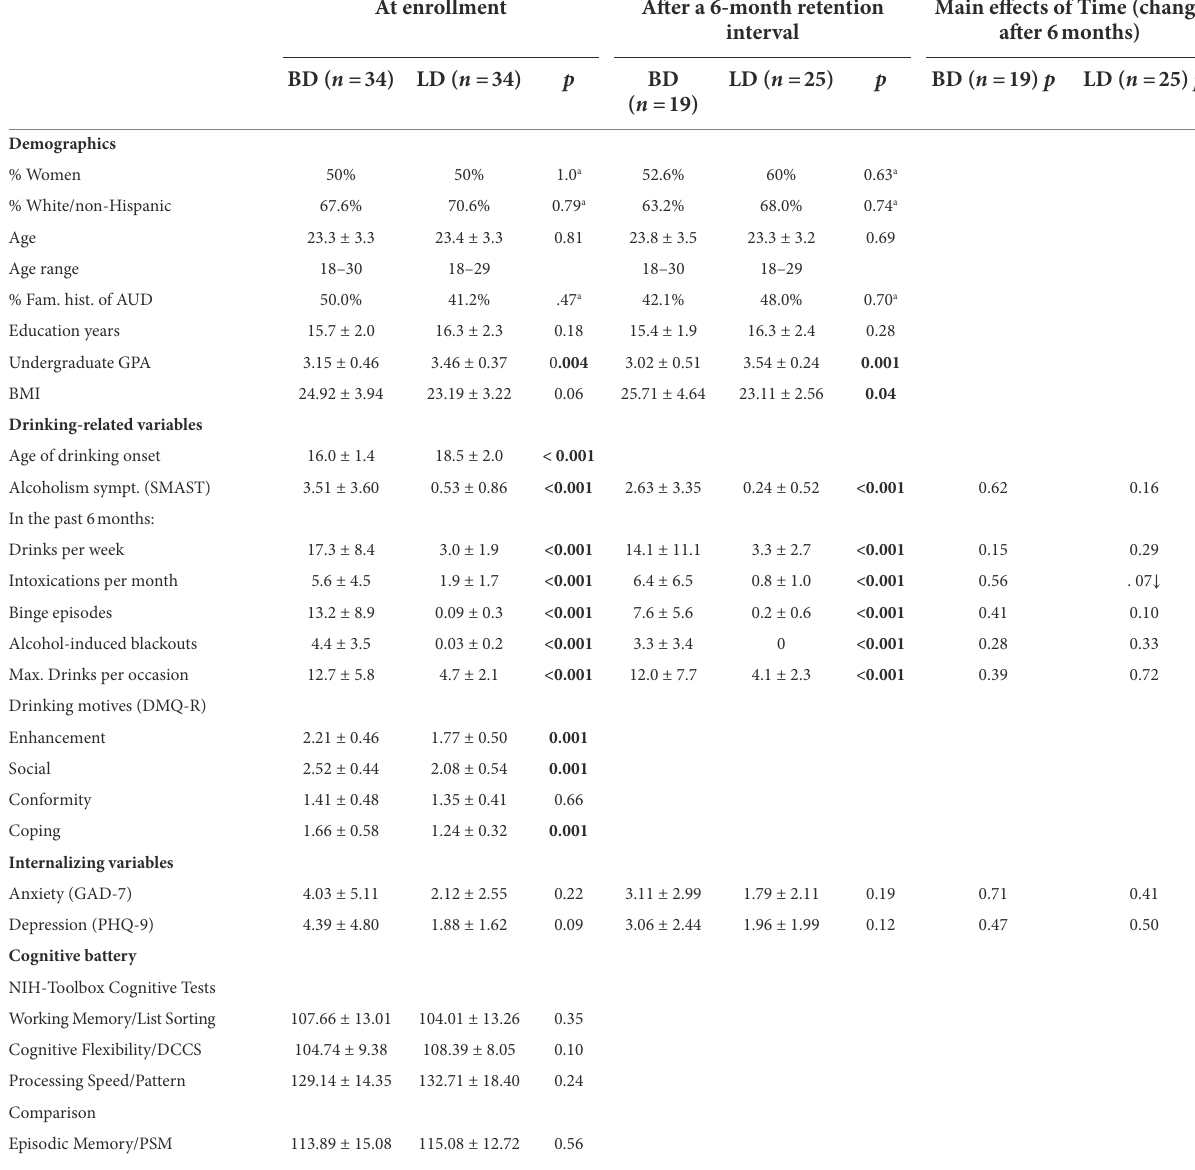
TABLE 1 Participant characteristics [Mean ± SD or n (%)] for the BD and LD groups assessed at enrollment and at a 6-month retention